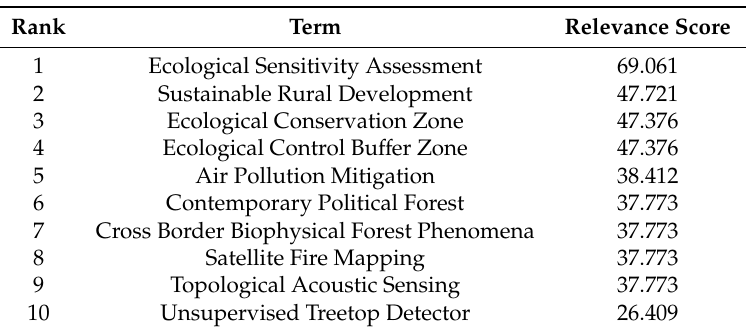
Table 4. Main terms by score